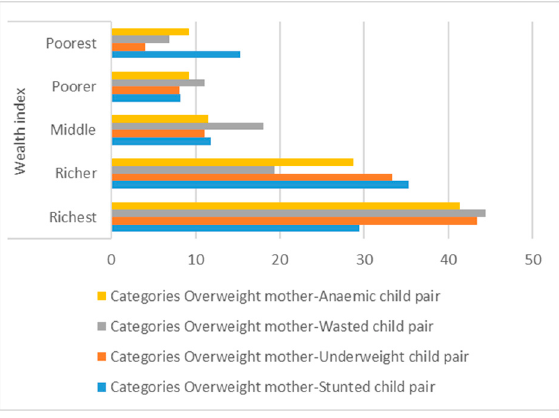
Figure 3. Distribution of DBM across the wealth index.